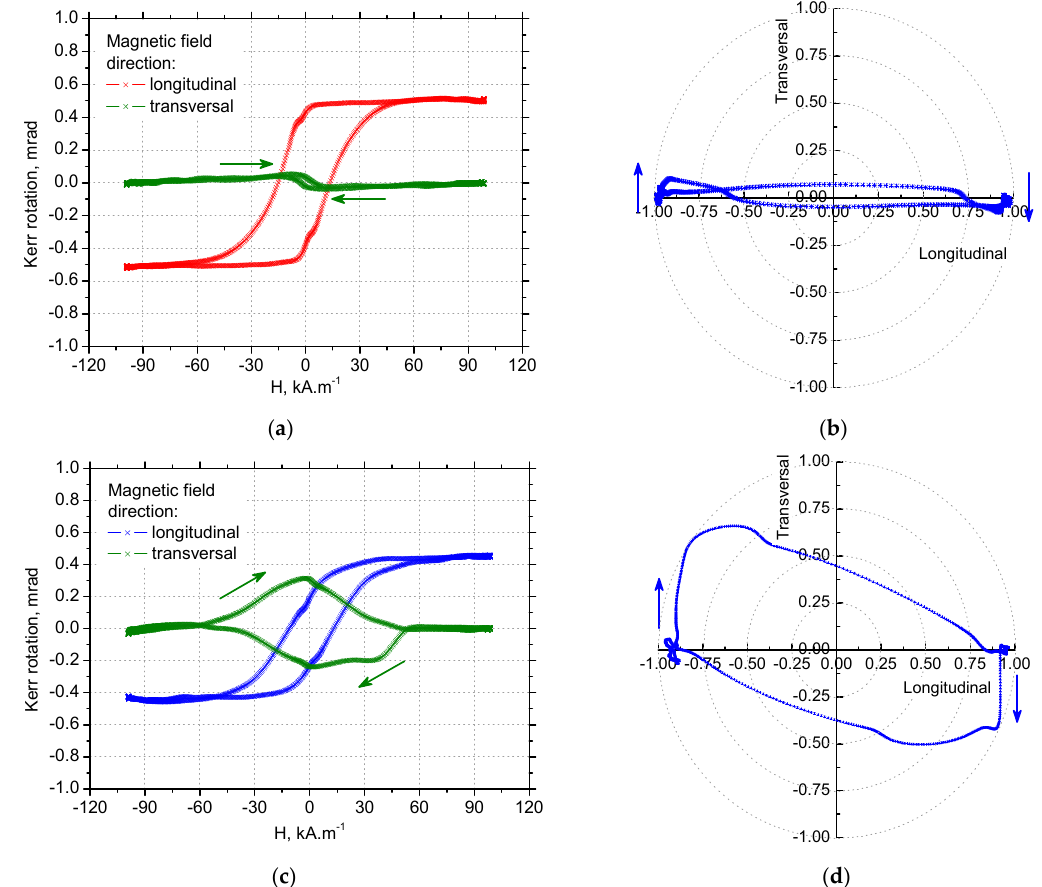
Figure 20. Hysteresis loops and polar graphs for VB = 0.4 mm, normalized: ( a ) hysteresis loops for the tangential direction, ( b ) polar graph for the tangential direction, ( c ) hysteresis loops for the axial direction, and ( d ) polar graph for the axial direction.